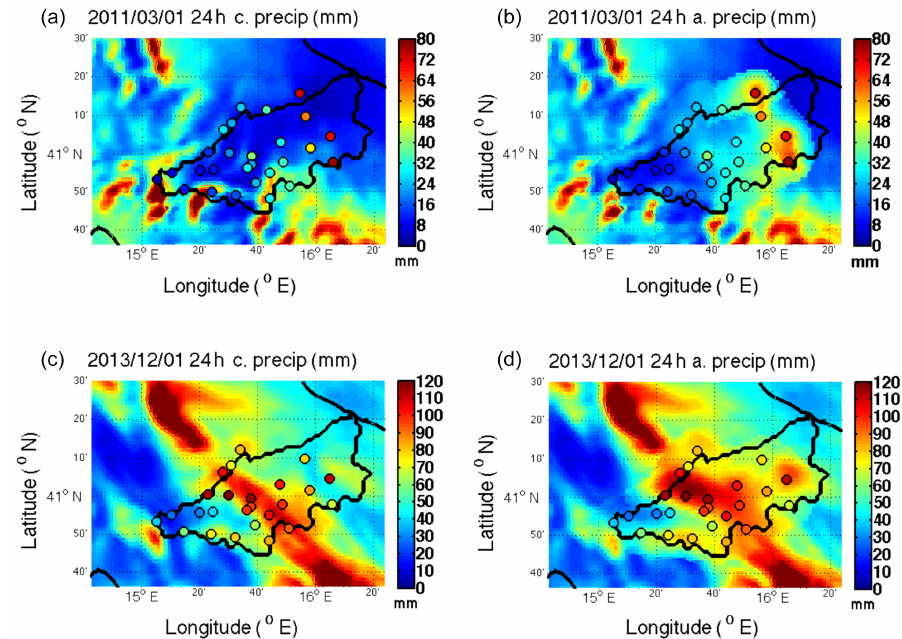
Figure 5. Maps of 24h cumulated precipitations (in mmday − 1 , colours) during the peak events on 1 March 2011 (top panels) and 1 Decem- ber 2013 (bottom panels). Shaded maps of modelled (left panel) and assimilated (right panel) precipitation with overlapped observed spots over the Ofanto